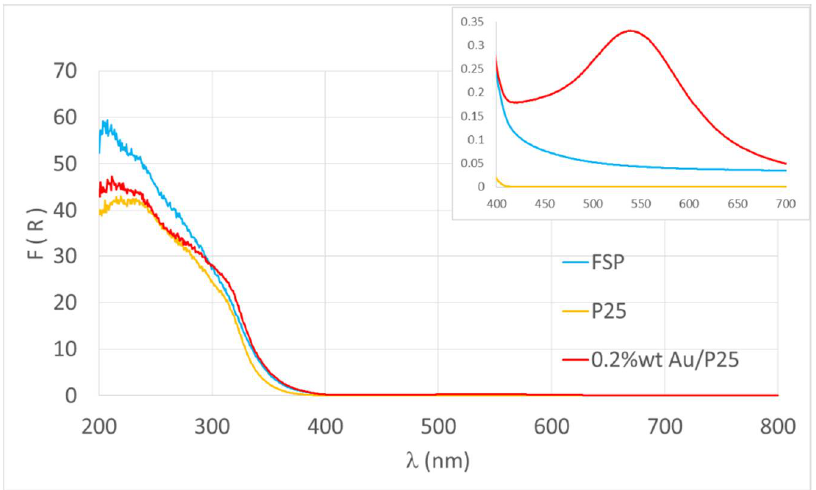
Figure 3. DR-UV spectra of the different samples. Inset: zoom of the visible portion of the spectrum. The production rates of the various compounds analyzed in our pilot photoreactor with the UV medium-pressure lamp are summarized in Table 3. As an order of magnitude, the maximum productivity of hydrogen that has been achieved in our high-pressure reactor when using P25 as photocatalyst and a 150 W/m 2 UV irradiance was nearly 4.00 mol H2 /h kg cat , for HCOOH was 39.36 mol HCOOH /h kg cat and for CO 0.23 mol CO /h kg cat . In the cases of HCHO and CH 3 OH, the production rate was far lower, so they are included in the list but are irrelevant and thus not considered for the subsequent calculation of energy storage efficiency. Table 3. Production rate values of the relevant products obtained with different photocatalysts (P25, FSP and